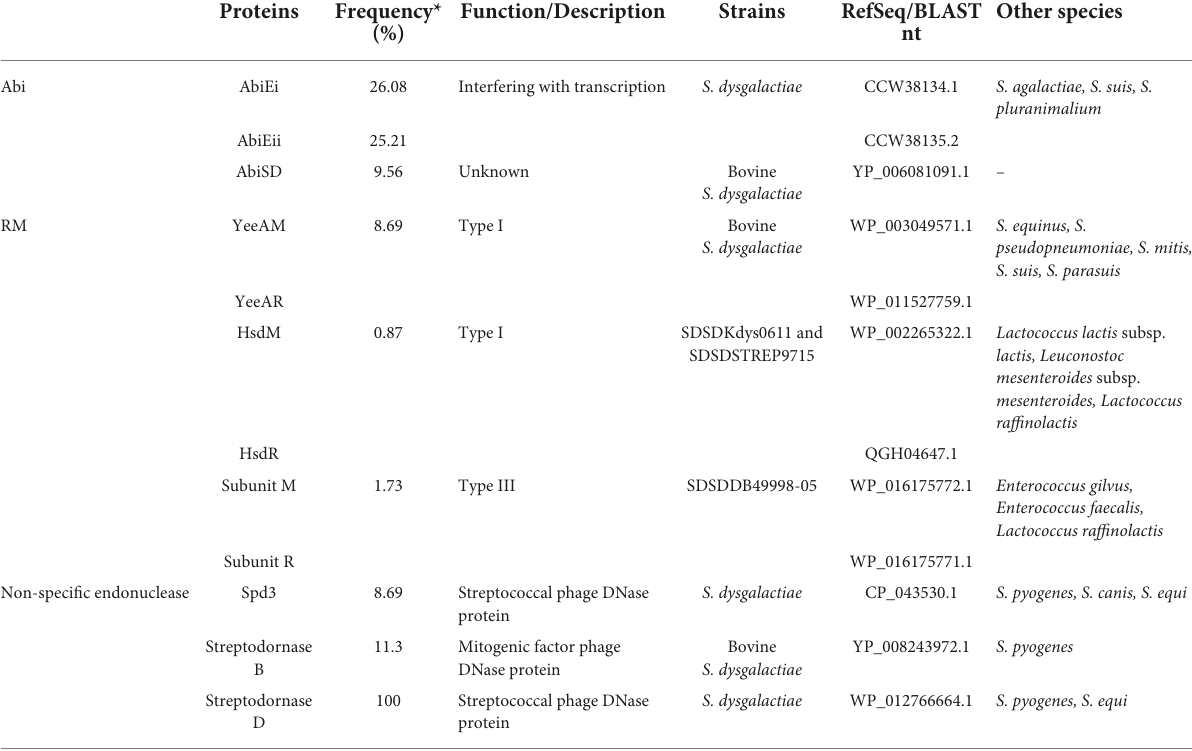
TABLE 3 Distribution of the Abi and RM systems and non-specific endonuclease of S.